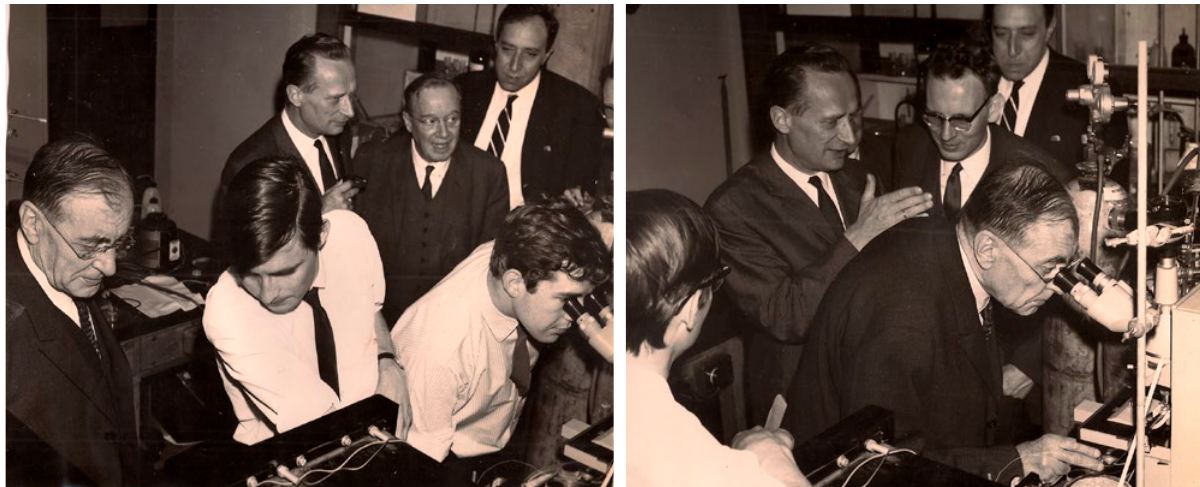
Figure 1. B. Derjaguin in his